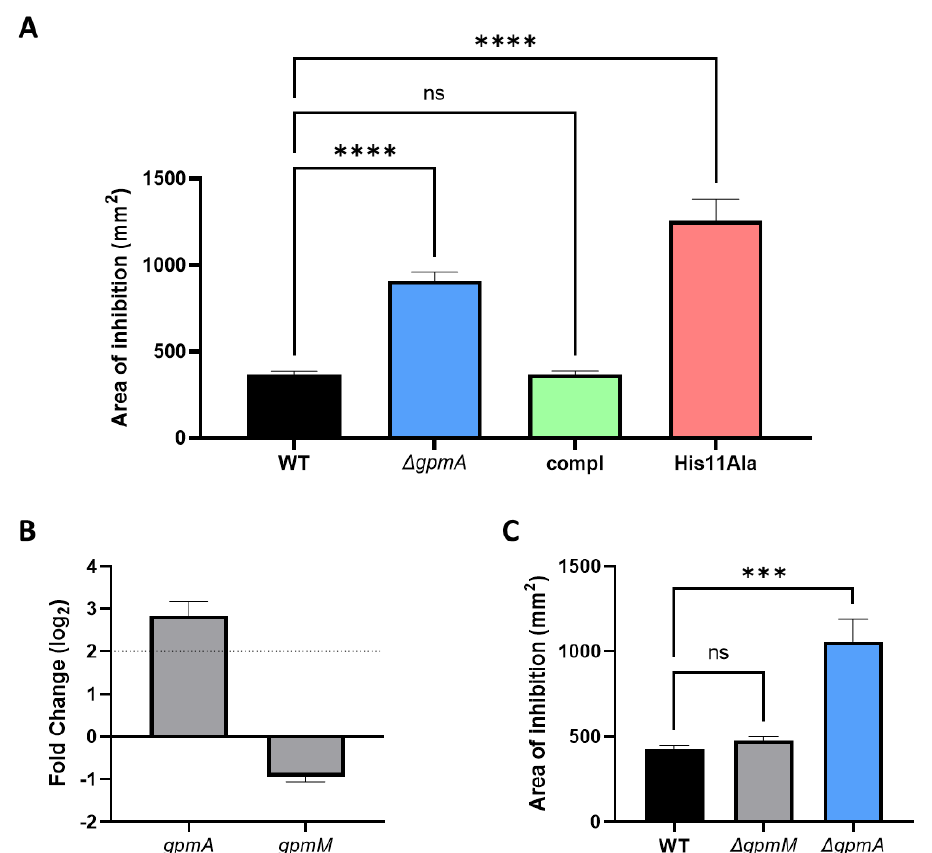
Figure 7. The function of gpmA, but not gpmM , is necessary to reach WT level of H 2 O 2 tolerance. ( A ) Sensitivity to H 2 O 2 assessed by disk diffusion assay for the WT with the empty plasmid, the ∆ gpmA mutant with the empty plasmid, the ∆ gpmA mutant with the plasmid encoding the native sequence of gpmA (compl) and the ∆ gpmA mutant complemented with the plasmid encoding gpmA with the replacement of the histidine 11 by an alanine (His11Ala). All tests were performed in LB + ampicillin. Data were analyzed by one-way ANOVA with Tukey test for multiple comparison and **** correspond to p < 0.0001 (mean +/ − SD, N = 3). ( B ) Differential expression of gpmA and gpmM 10 min after exposition to 2.5 mM H 2 O 2 compared to no treatment (mean +/ − SD, N = 4). Data from previously performed RNA-seq (deposited on ENA with the accession number: PRJEB51098) [10]. ( C ) Sensitivity to H 2 O 2 assessed by disk diffusion assay of WT, ∆ gpmA and ∆ gpmM mutants. Data were analyzed by Welch t -test and *** correspond to p < 0.001 (mean +/ − SD, N = 3).